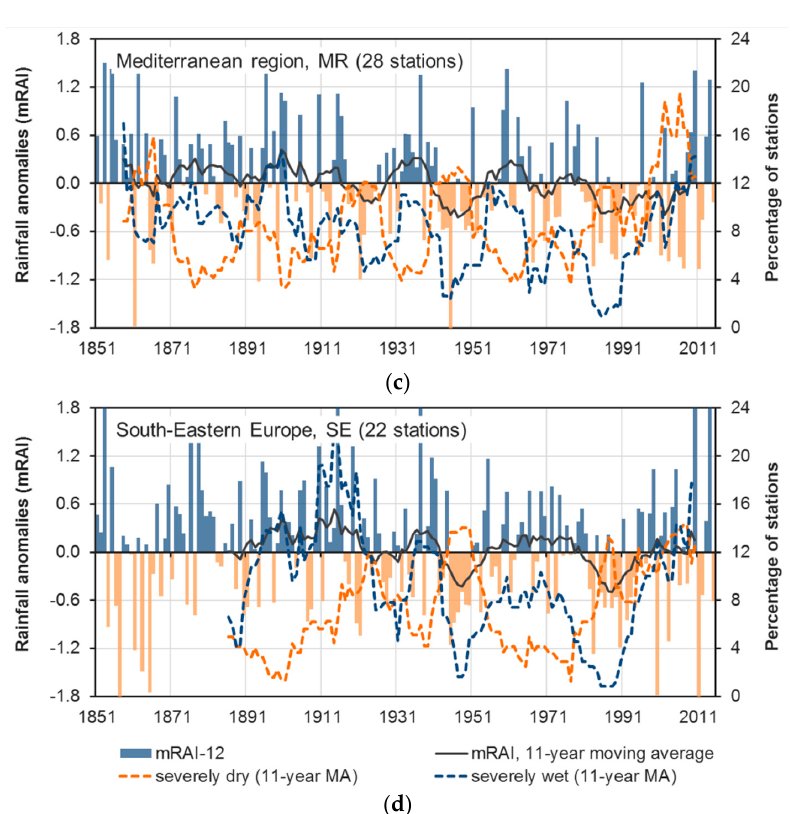
Figure A2. Time series of annual precipitation anomalies as well as the percentage of stations under severely dry and wet conditions, respectively, for the regions ( a ) WE, ( b ) IP, ( c ) MR, and ( d ) SE; 1851–2015.